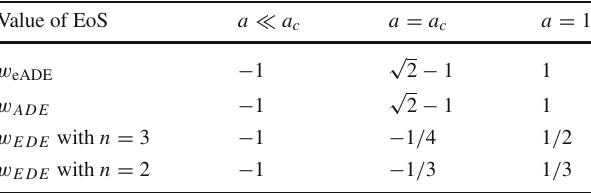
Table 1 The benchmark point of EoS for eADE, ADE, and EDE model at different cosmic scale factor a . For the EDE model, we select the parameter n equal to 2 and